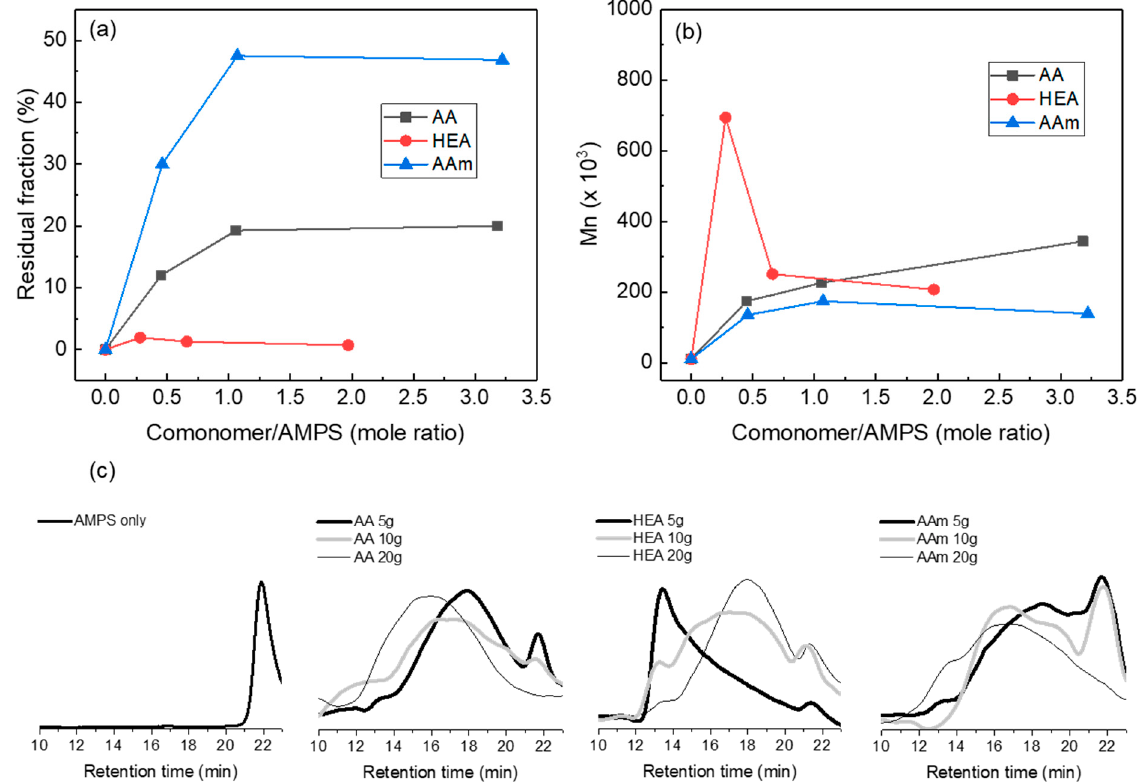
Figure 2. Residual fraction (%) of AMPS/comonomer hydrogels remained after extraction ( a ), number average molecular weight of the polymers isolated from AMPS/comonomer hydrogels ( b ), and AMPS/comonomer hydrogels water–GPC chromatograms ( c ). In this experiment, AMPS/comonomer hydrogels were prepared with a 5 kGy E-beam dose without PEGDA, and the number average molecular weight was calculated from the main peak in the water–GPC chromatograms.